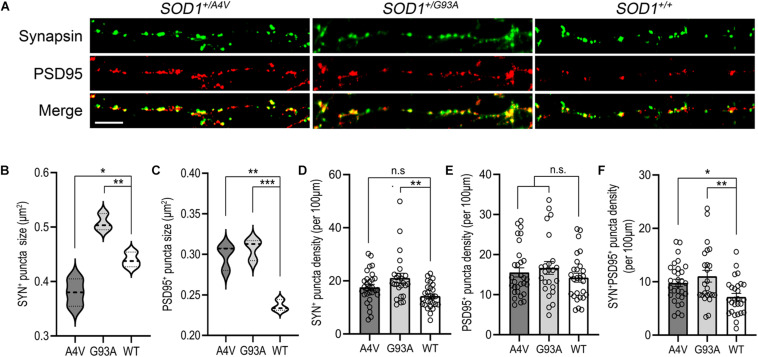
Synaptic structure abnormalities in SOD1+/A4V and SOD1+/G93A MNs. (A) SYN+ and PSD95+ immunofluorescence staining decorating MN processes with pre- and postsynaptic puncta. Scale bar, 10 μm. (B,C) Quantification of (B) SYN+ and (C) PSD95+ puncta sizes. (D–F) Quantification of (D) SYN+, (E) PSD95+, and (F) SYN+PSD95+ puncta density (per 100 μm). Each dot indicates a dendrite analyzed. All data shown as mean ± SEM. *p < 0.05, **p < 0.01, ***p < 0.001.